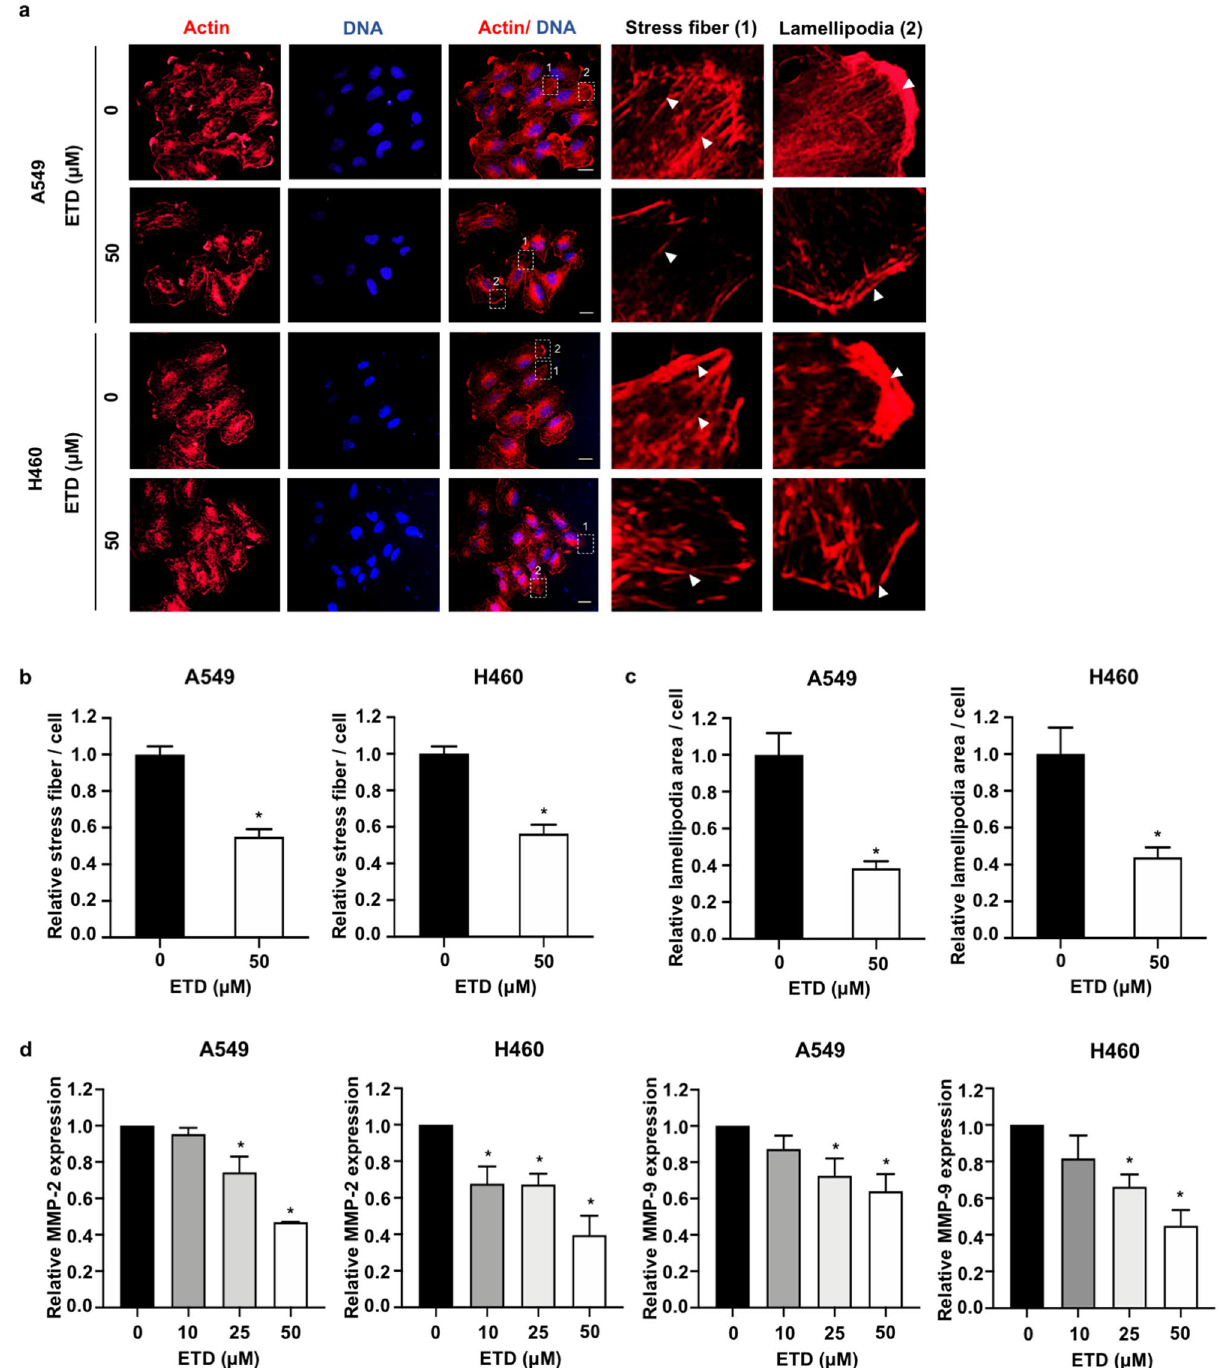
Figure 3. ETD suppresses cell migration and invasion via alteration of actin stress fiber organization and inhibition of MMP expression. ( A ) A549 and H460 cells were cultured on cover slips and treated with 50 µM ETD for 48 h. Cells were stained with phalloidin (actin, red) and DAPI (blue) and observed by confocal microscopy at ×20 magnification. The images in the box are enlarged in the right panel. Arrows indicate actin stress fibers and lamellipodia. The scale bar is 20 µm. ( B ) The number of stress fibers per cell and ( C ) the area of lamellipodia per cell were analyzed relative to those of the control group using ImageJ 54 . The data are presented as mean ± SEM from at least 50 cells. * p < 0.05 vs untreated control group. ( D ) Cells were treated with 0–50 µM ETD for 48 h, and MMP-2 and MMP-9 mRNA expressions were quantified by quantitative RT-PCR. The mRNA expression level of the treatment group was calculated relative to that in the control group. The data are presented as the mean ± SEM (n = 3). * p < 0.05 vs untreated control